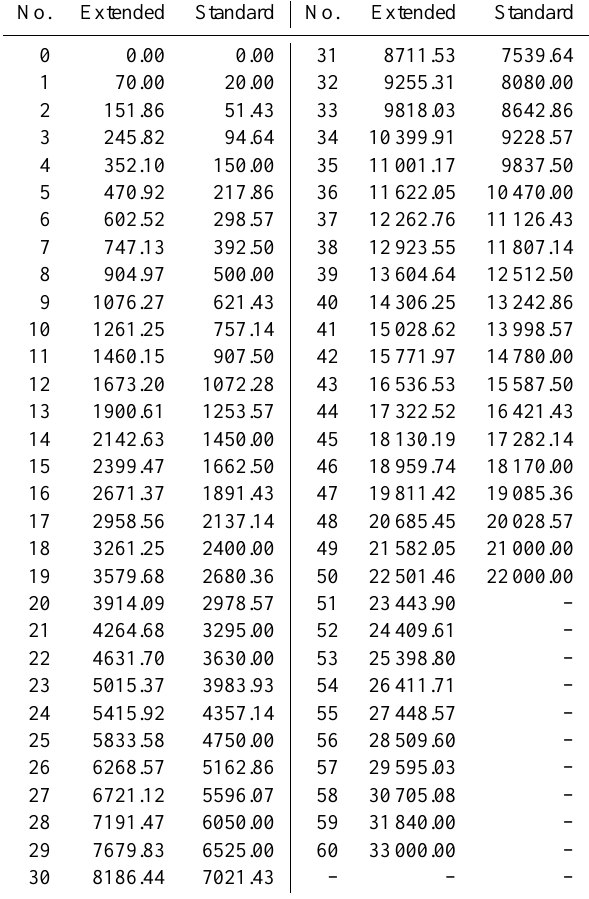
Table A1. Heights of the layers of the standard and the extended COSMO grid, specified in meters.